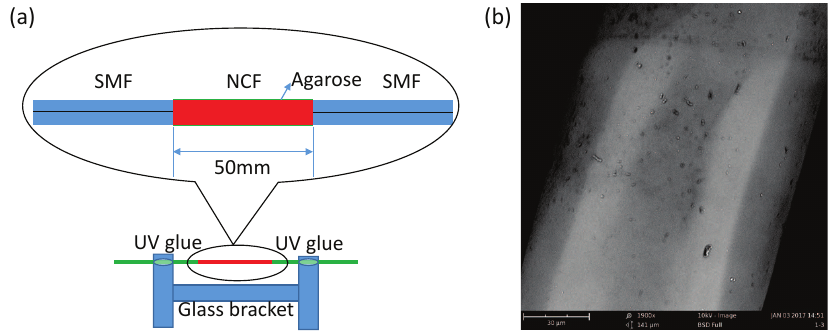
Figure 1. ( a ) The single-mode–no-core–single-mode fiber (SNCS) sensor fixed on an I-shaped glass bracket with UV glue and its details in the marked area; ( b ) SEM photo of the sensor coated by 0.1 wt/vol % agarose solution. SMF: single-mode fiber; NCF: no-core fiber.